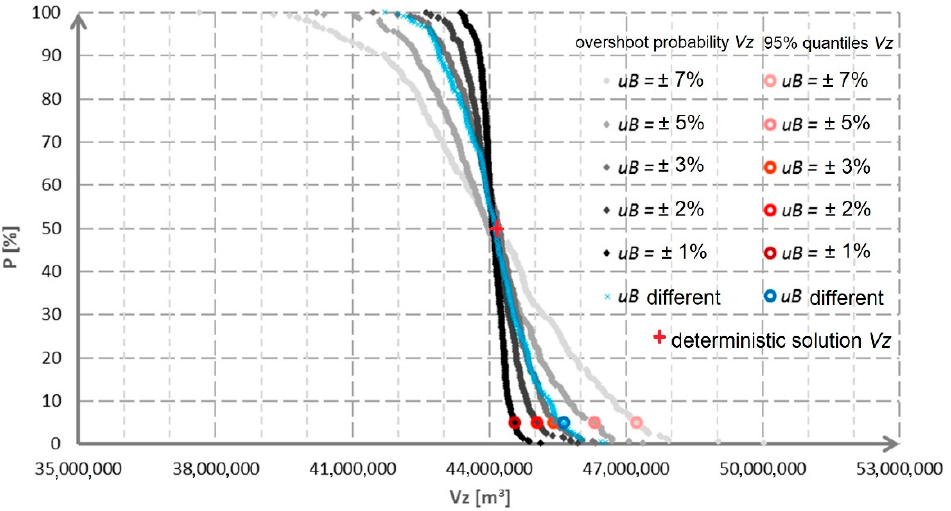
Figure 7. Overshoot probability curves for the resulting optimized storage volumes of the tested reservoir for different sizes of input uncertainties.